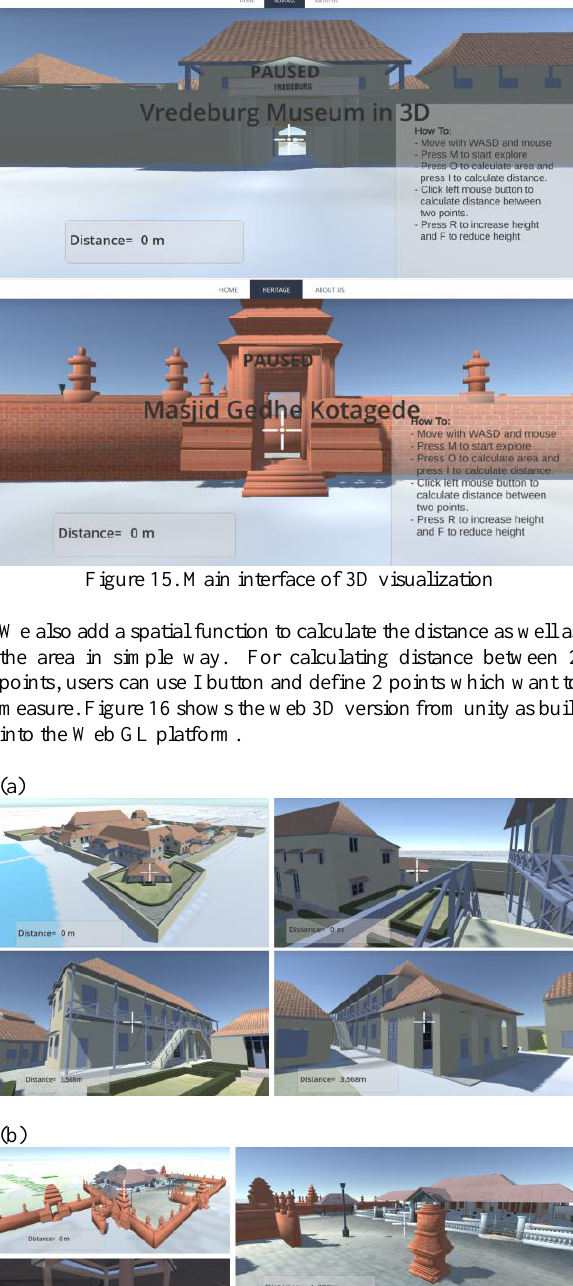
Figure 14. 3D primitive model at Vredeburg Fort Museum (a) and Kotagede Great Mosque (b)